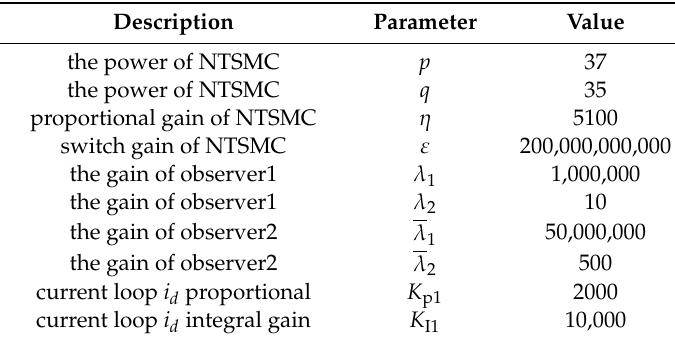
Table 4. The proposed controller this